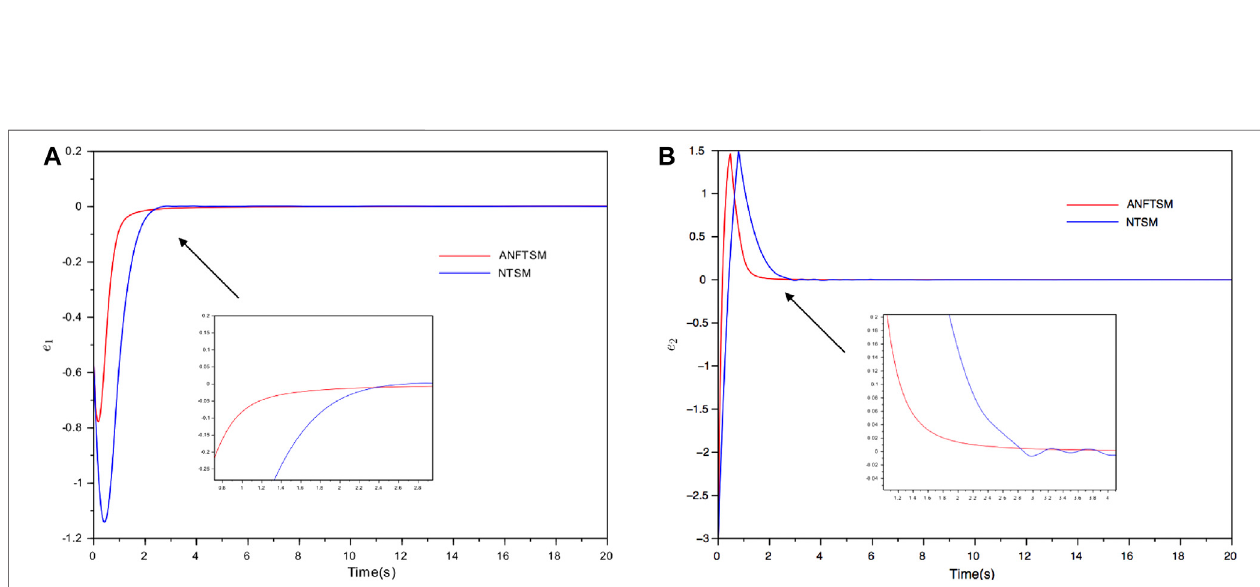
FIGURE 8 | Synchronization between the Duf fi ng-Holmes and the Power systems in Example 2 by NTSM controller (A) the synchronization of x 1 and y 1 (B) the synchronization between x 2 and y 2 .